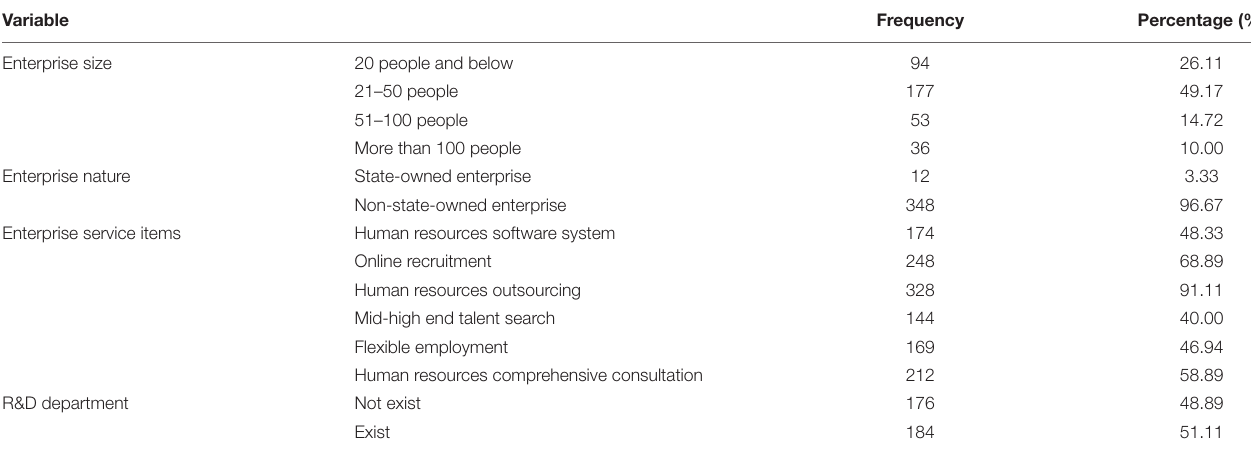
TABLE 1 | Basic characteristics of the